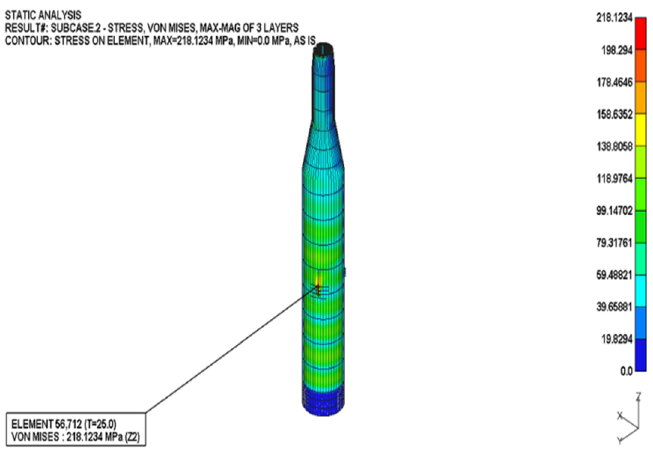
Figure 15. Equivalent stress distribution (LC06).